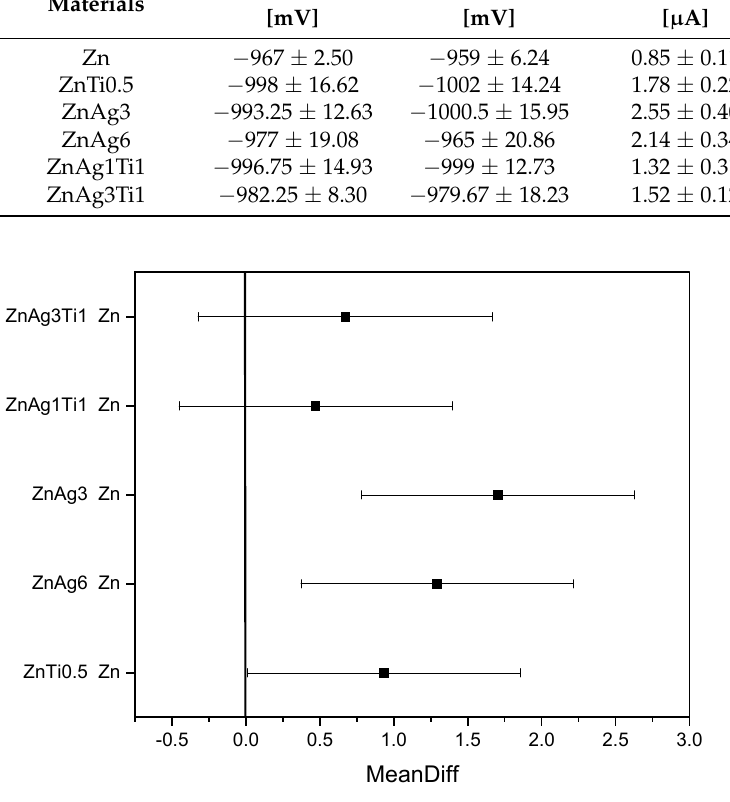
Figure 5. Mean difference of corrosion current after ANOVA between zinc and the tested alloys.